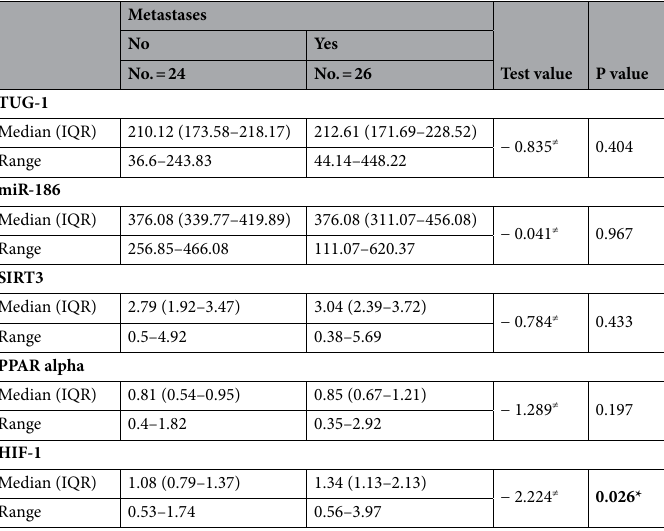
Table 3. Relationship between metastases and the different studied parameters in TMX‑resistant group. P value > 0.05: non significant; P value < 0.05: significant*; P value < 0.01: highly significant**. Significant values are in [bold]. ≠ Mann–Whitney test.